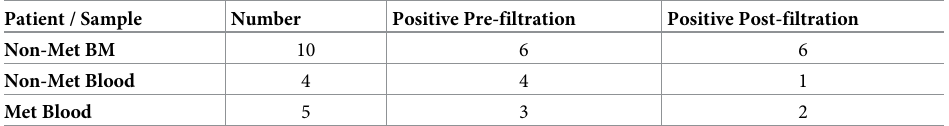
Table 2. Gene expression in blood or BM pre- and post-filtration based on expression of one or more gene marker